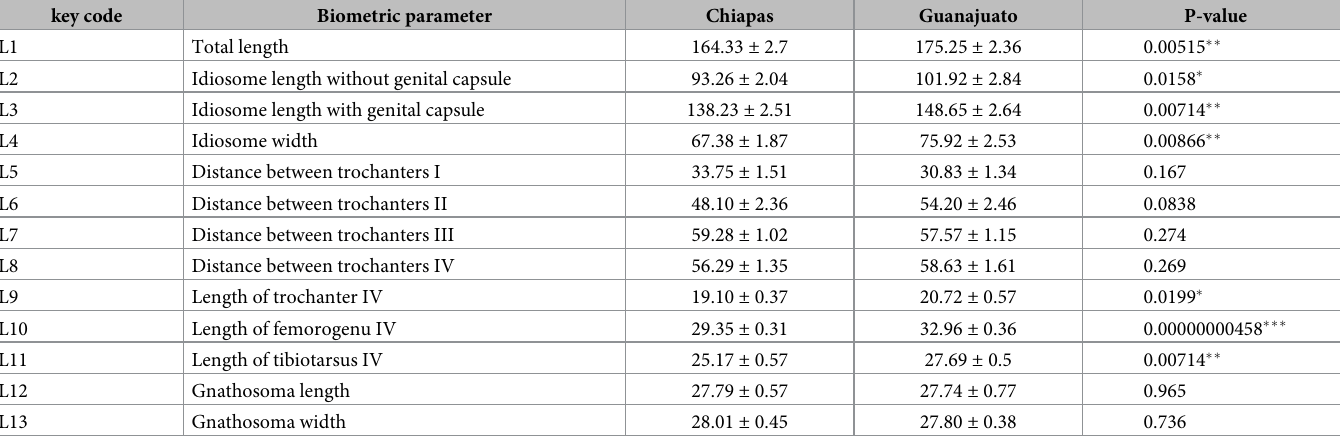
Table 3. Comparison of averages of biometric parameters in male specimens of Polyphagotarsonemus latus collected in Chiapas and